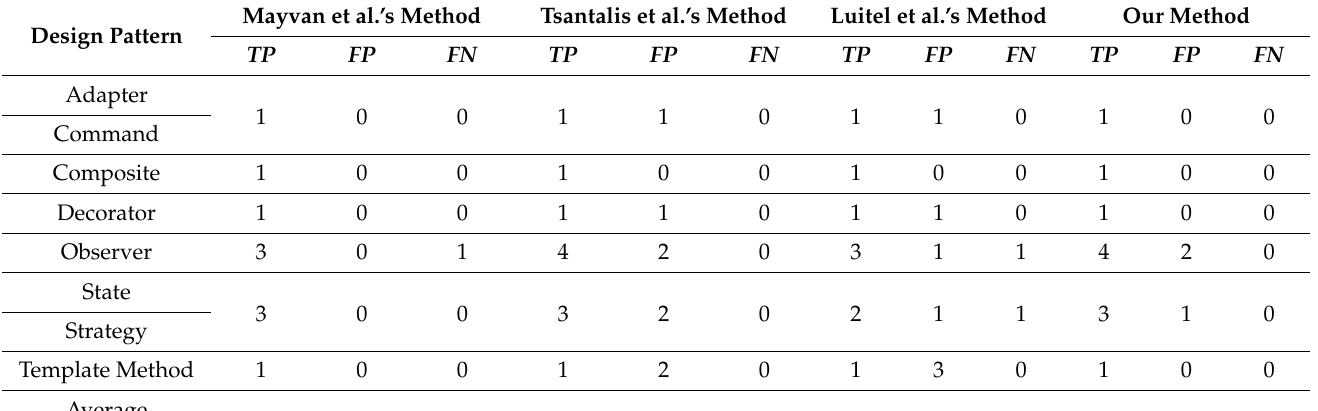
Table 4. The number of true positive instances, the number of false positive instances and the number of false negative instances in JUnit 3.7.